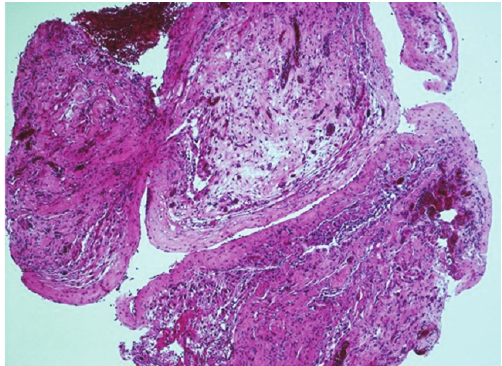
Figure 6: The biopsy from the lower thoracic dura showed fibrous tissue lined by meningothelial type of cells with nests of moderately pleomorphic cells. These cells appeared fibrillary, rounded, and occasionally gemistocytic or multinucleated. Proliferating vascular clusters were present as well. Occasional round cells were seen forming clusters in